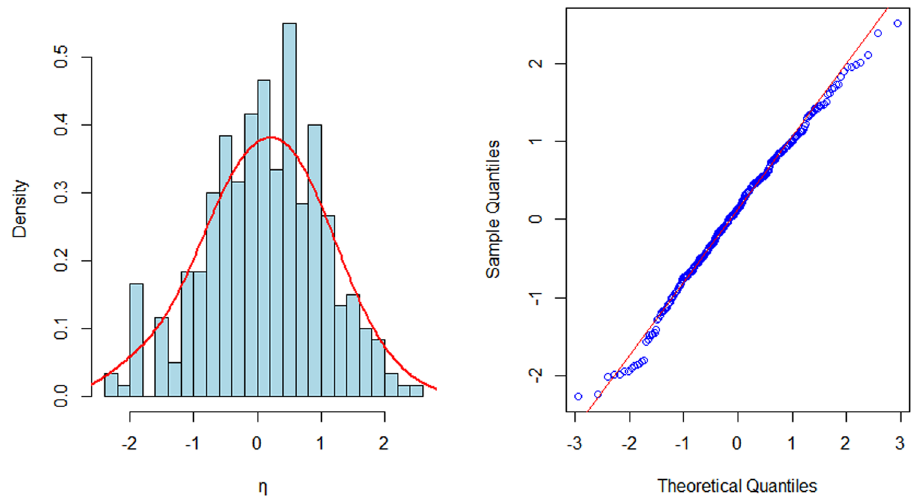
Figure 2: Histogram and normal Q – Q plot of